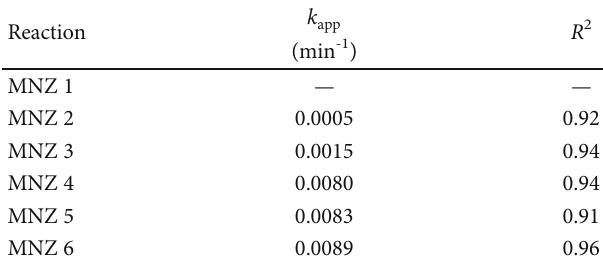
Table 6: Apparent rate constant of RB5 dye degradation.